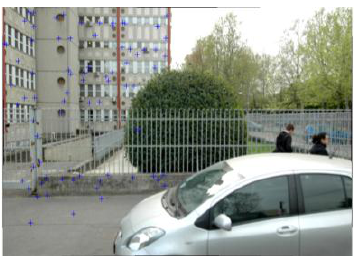
Figure 5. Problems in automatic tie points extraction in presence of obstacles